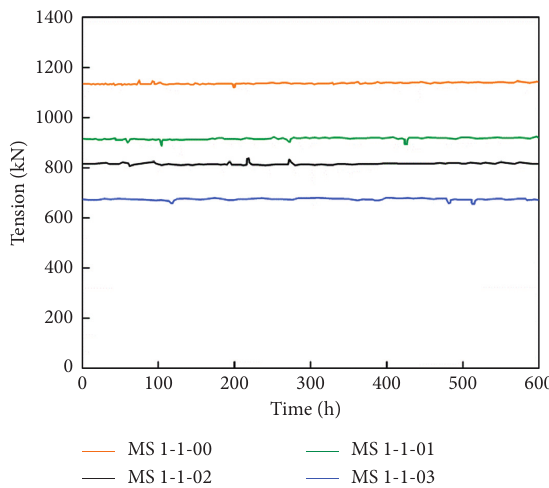
Figure 5: Test result curve of the anchor cable dynamometer in the soil filling test.